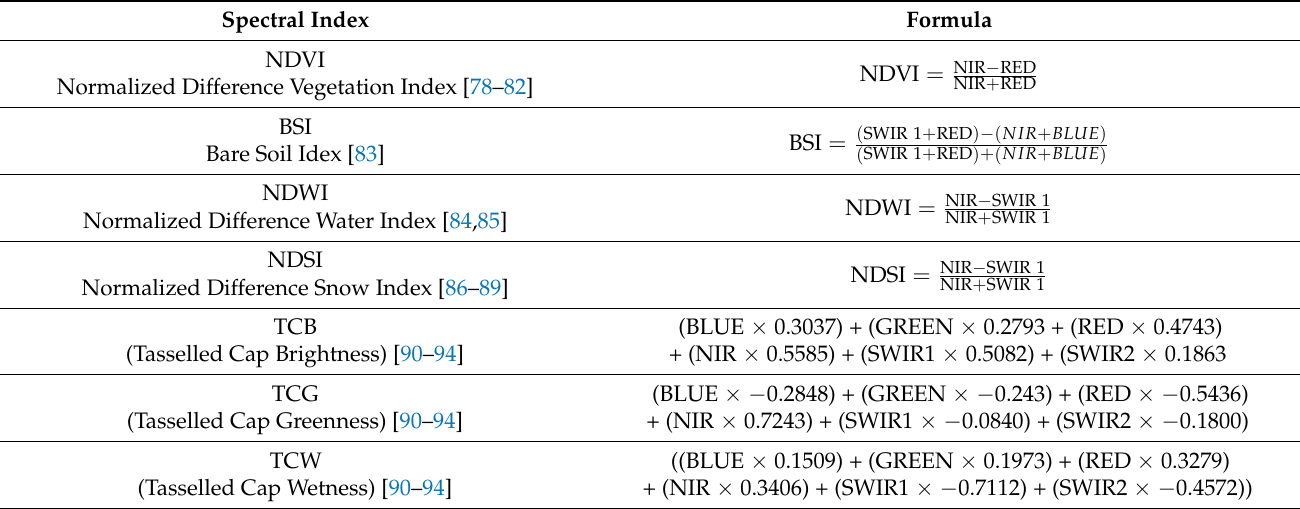
Table 5. Multispectral